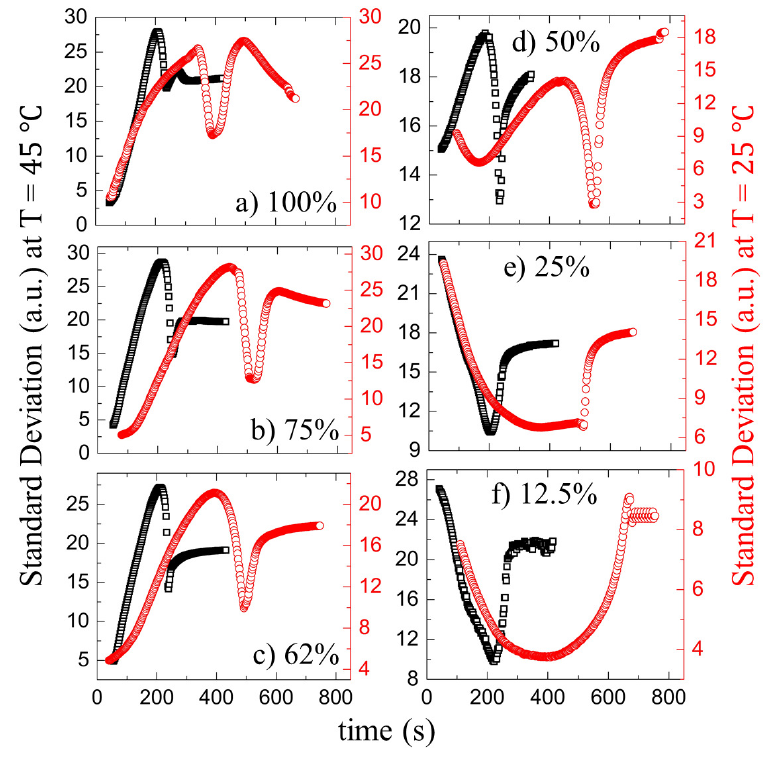
Figure 6. Time evolution of the statistical image parameter, the standard deviation [in arbitrary units, (a.u.)] of the blood droplets at the different initial concentrations ( φ b ) of 100 to 12.5% ( v / v ), respectively, in ( a – f ). The black and the red colors represent the standard deviation at 45 and 25 ◦ C